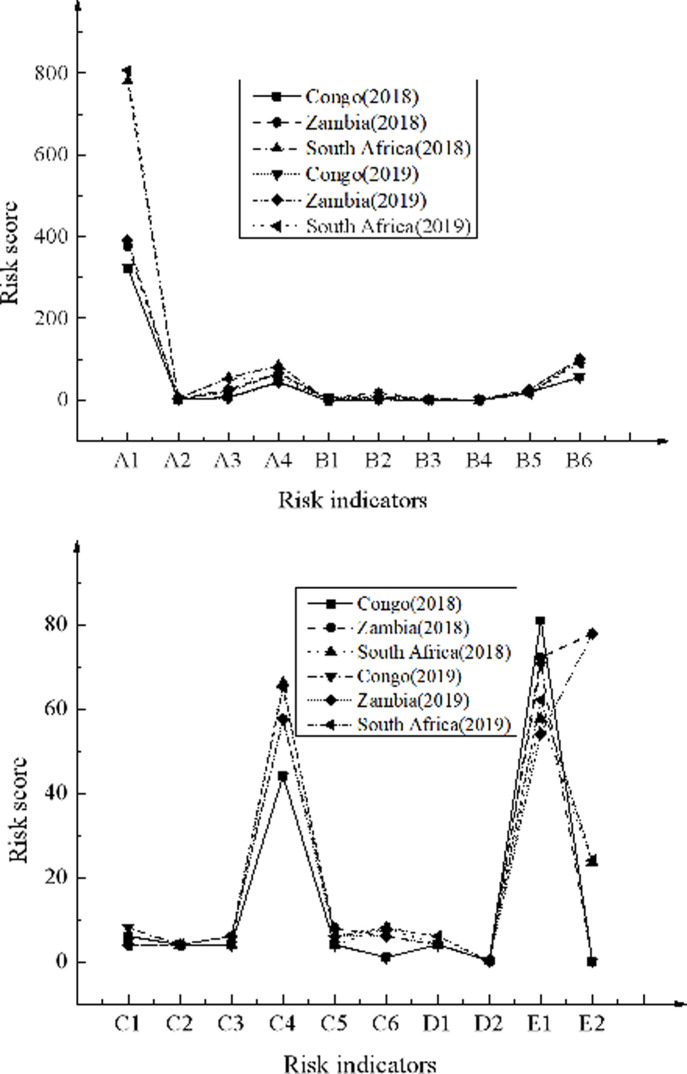
The results of the overseas investment risk assessment of African country clusters in 2018–2019.(a) Risk categories of basic resources and economic and finance; (b) Risk categories of political systems, environmental protection, and resources and energy.